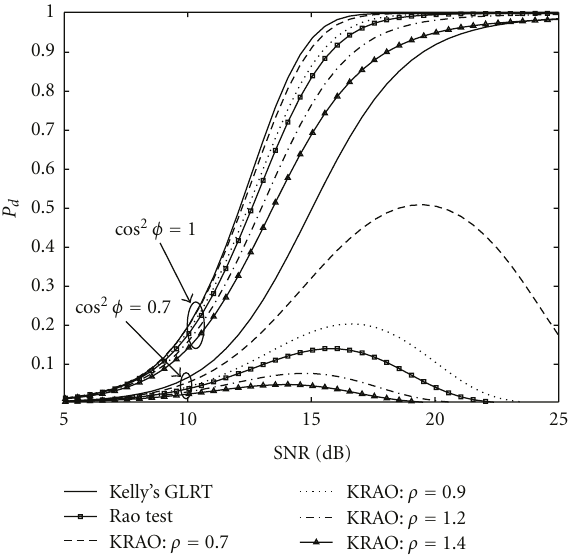
Figure 3: P d versus SNR for the KRAO, N = 8, K = 24, and ρ ∈ [0,0 . 5].